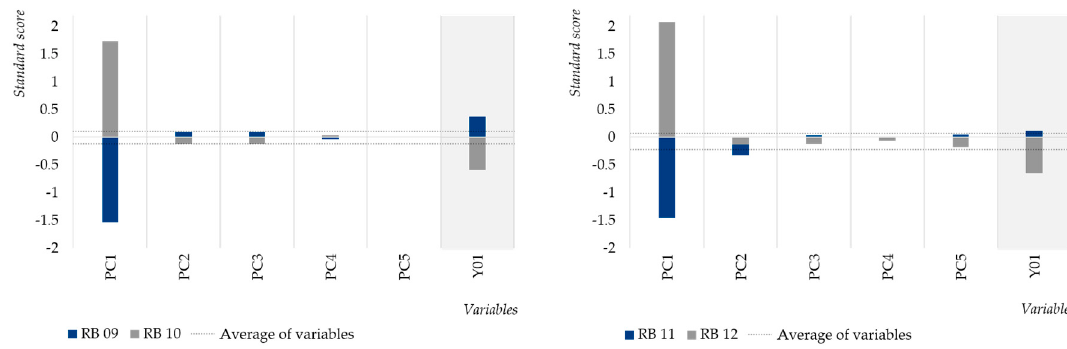
Figure 6. Cluster profile based on variables (left: method 5, right: method 6).